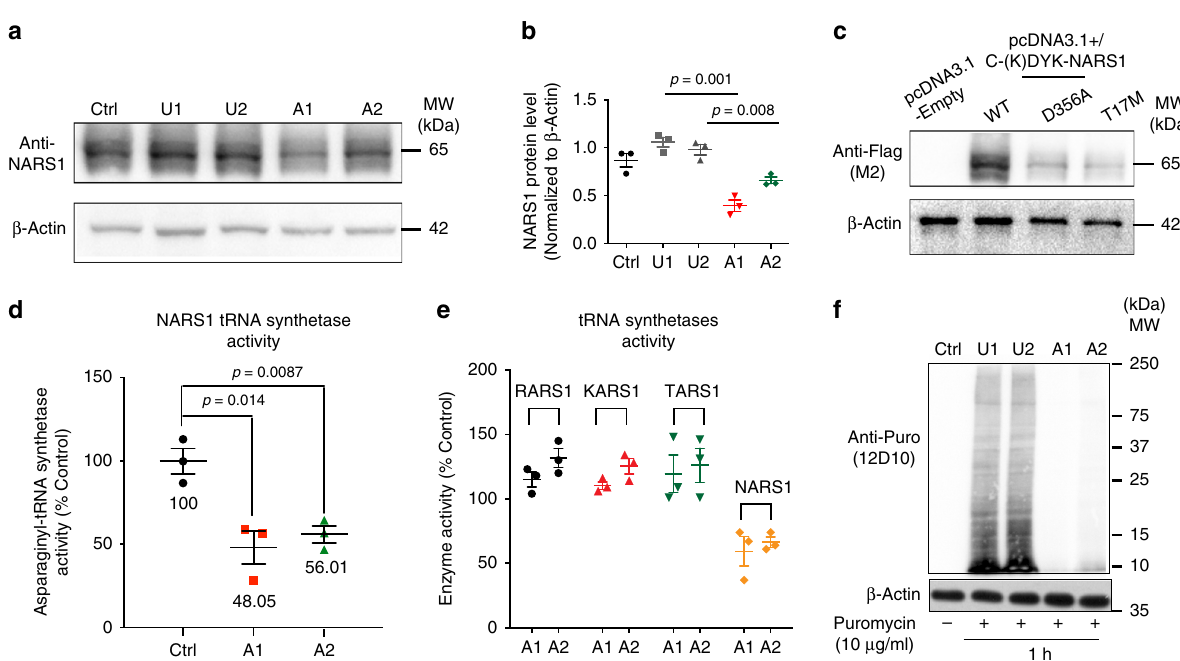
Fig. 2 Patients cells display loss of NARS1 functions. a Fibroblast cells from two unaffected (U1 and U2) and two affected (A1 and A2) show reduced levels compared with actin control. b Quanti fi cation results for WB, n = 3, Error bar: ± SD. c Overexpression in cDNA expressing patient variants in HEK293T cells showed unstable NARS1 protein. d Reduced NARS1 tRNA synthetase activity in patient fi broblasts. n = 3, Error bar: ± SD. e Other tRNA-ARS activity not impaired in NARS1 mutated cells. TARS: Threonyl-tRNA synthetase; KARS: lysyl-tRNA synthetase; RARS: arginyl-tRNA synthetase. n = 3, Error bar: ± SD. f Patient IPSCs showed reduced puromycin incorporation after 1 h pulse, indicating reduced protein synthesis. For the quanti fi cation data in ( b ) and ( d ), n = 3 represents three independent biological replicates, two-tailed p values based upon Student t- test with Holm – Š ídák multiple comparison correction, and individual p value was shown in ( b , d ); Source data are provided as a Source Data fi (Supplementary Fig. 3a, b, Supplementary Data 1). iPSCs from affected individuals were generally indistinguishable in measures of pluripotency and cellular health (Supplementary Fig. 3c, d) 43 .